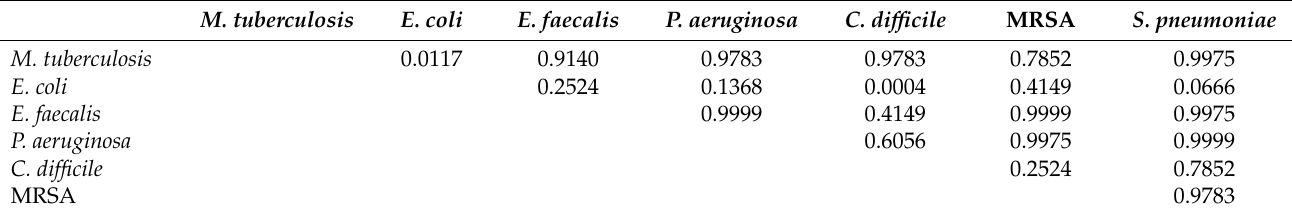
Table 6. Significance of the incidence of specific bacteria at both FD. p -values were obtained using Tukey–Kramer HSD adjustments for multiple comparisons to determine if one type of bacteria was more likely to be present than another.